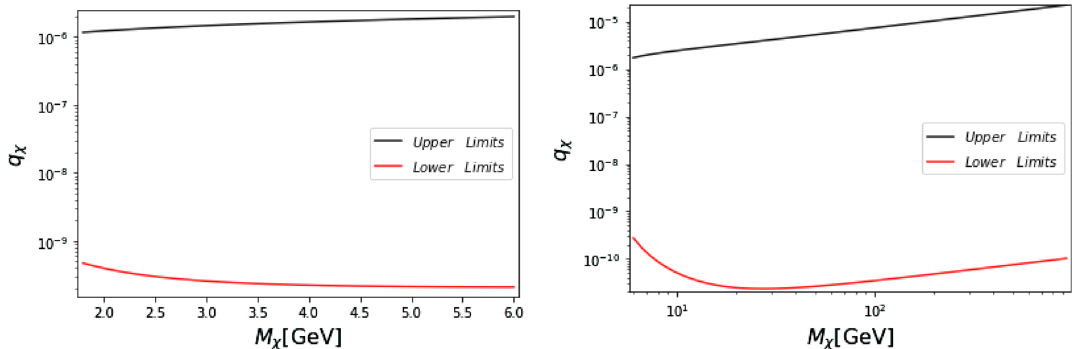
Fig. 11 The 90% exclusion on the DM millicharge q χ as a function of the DM mass using recasted results of DarkSide-50 (left) and of XENON1T (right). The region above the top curve cannot be probed by underground DD